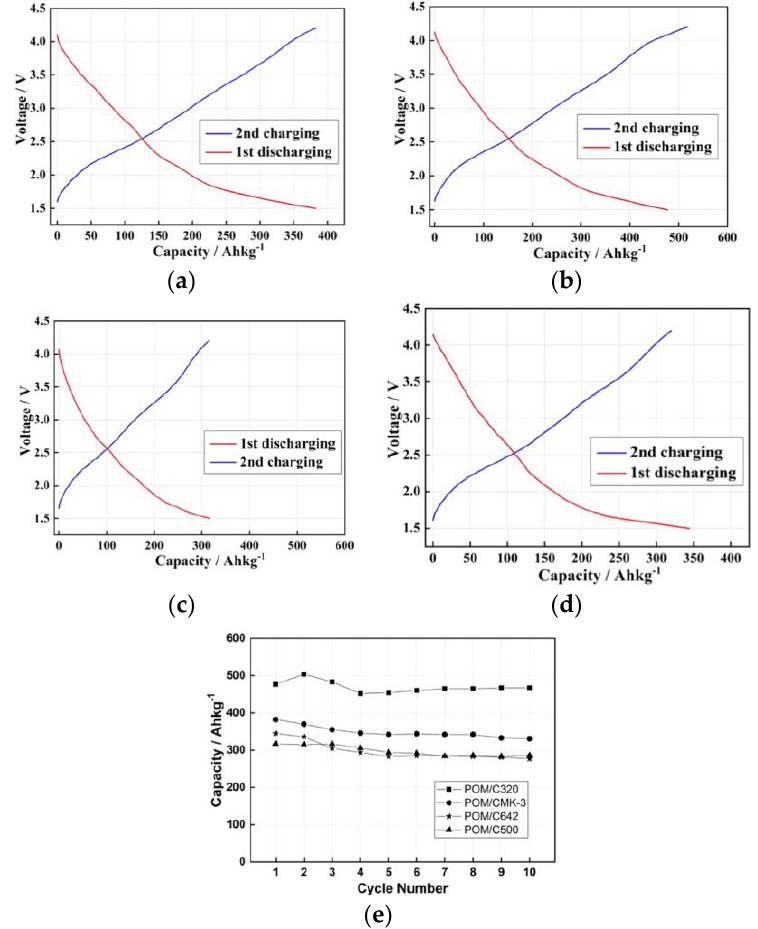
Figure 3. First discharge and second charge curves in the voltage range of 1.5–4.2 V with a constant current of I = 1.0 mA for ( a ) POM/CMK-3, ( b ) POM/C320, ( c ) POM/C500, ( d ) POM/C642. ( e ) Cycle performance for POM/CMK-3, POM/C320, POM/C500, and POM/C642.